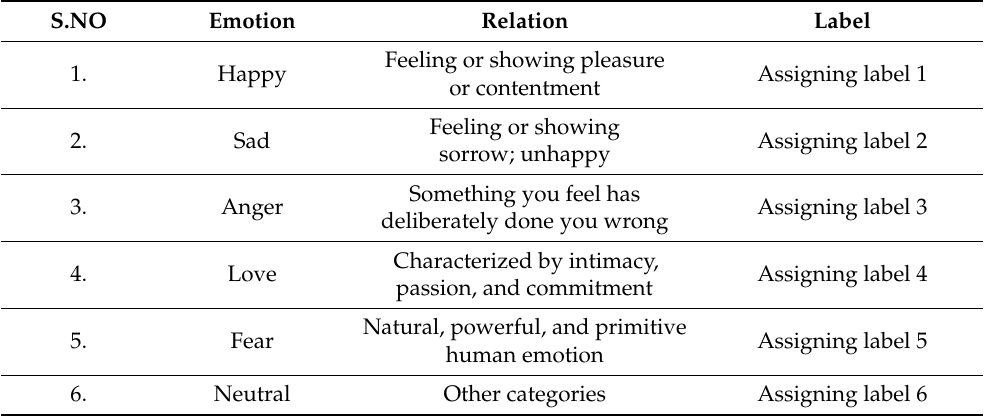
Table 3. Selected Emotion Examples with